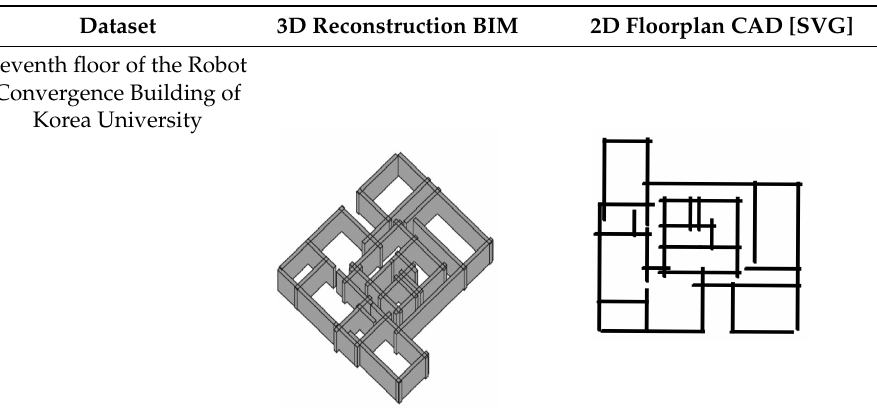
Table 4. Result of the proposed